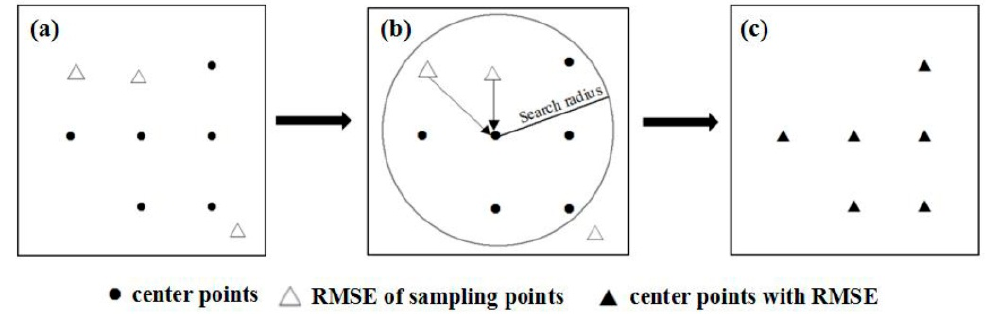
Figure 4. The schematic diagram of spatial uncertainty evaluation method. ( a ) extract the center points by creating a fishnet structure covering the region of grassland; ( b ) assign the sampling points’ value by calculating the average value of all points within a certain distance; ( c ) complete calculation of all points in window and go to next window until finish all points.